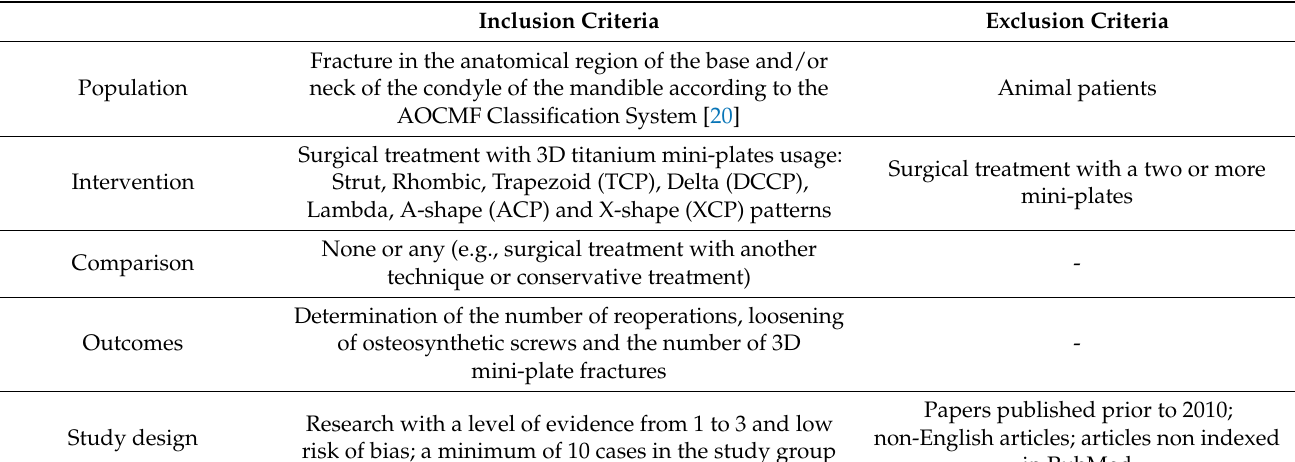
Table 1. Brief summary of the PICOS eligibility criteria for the systematic review [19]. Inclusion Criteria Exclusion Criteria Animal